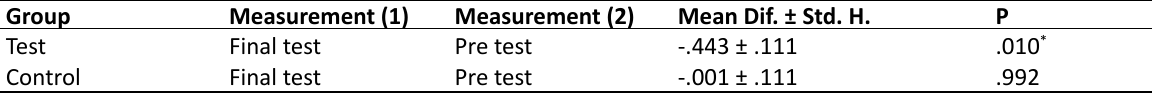
Table 7. Body Fat Percentage values simple effect test results Group Measurement